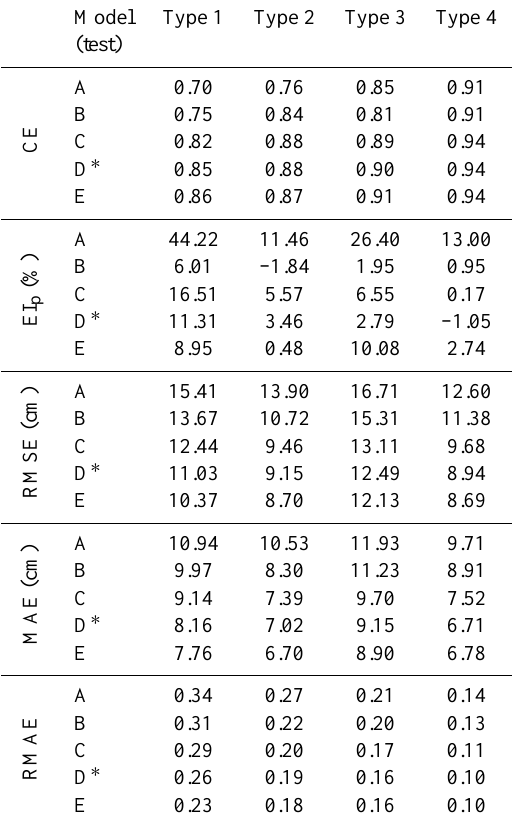
Table 5. Performance of RiHNNs for the four types of rainfall in test